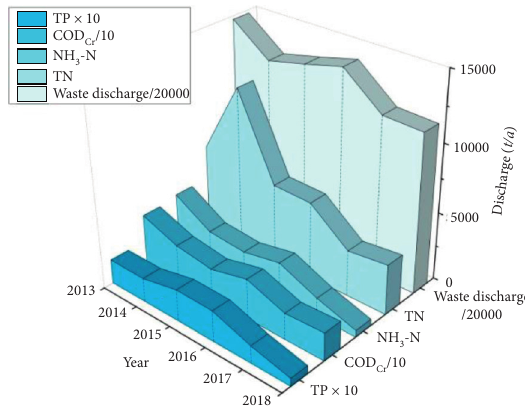
Figure 8: Discharges of wastewater and major pollutants into the